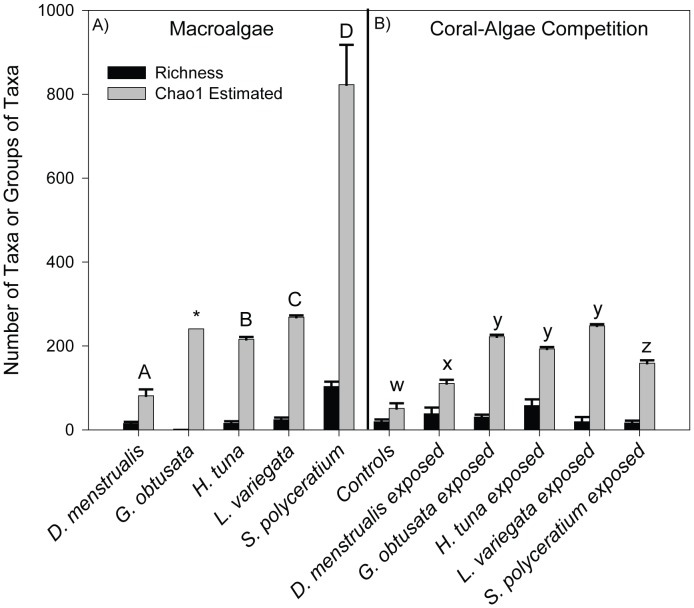
Comparisons of relative bacterial diversity among macroalgal species and among coral-algal competition treatments.The presence of individual TRFs were used to determine bacterial species richness (black bars) and CHAO 1 estimates (grey bars) were used to predict the relative number of taxa (means ± SE) in macroalgae (A) and on corals challenged with macroalgae (B). Letters represent significant differences (p<0.05) in CHAO1 estimates among sample types; richness was not found to be significantly different among samples. Differences among macroalgae are denoted by uppercase letters A-D while difference among coral-algae treatments and controls are denoted by lowercase letters w-z. *Galaxaura obtusata macroalgae data were not included in statistical analysis due to low replication.